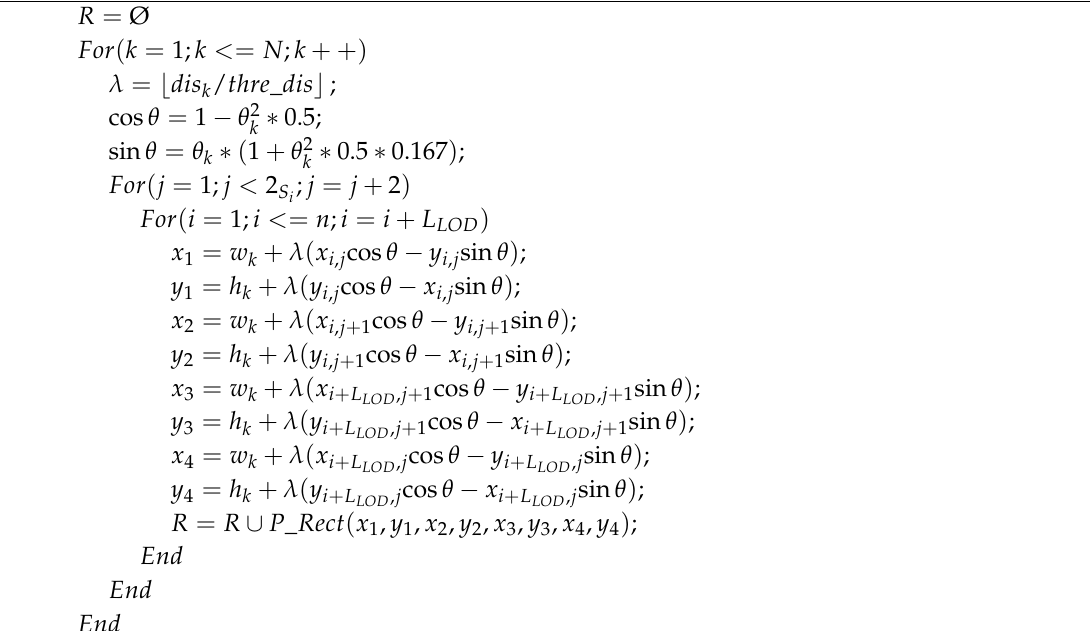
Algorithm 3: The process of calculating the erasure area R